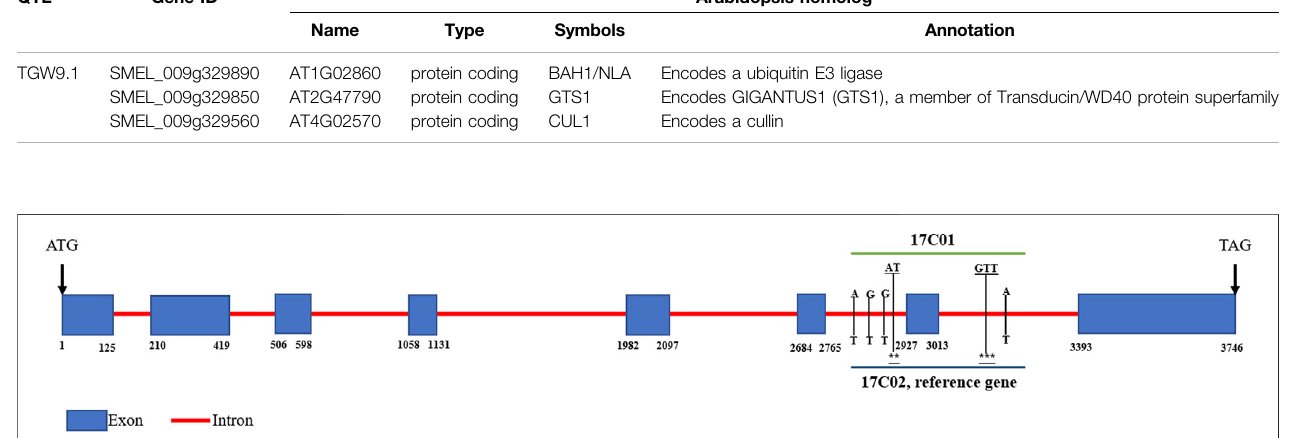
FIGURE3| Thegenomicsequence alignmentsofSMEL_009g329850 between17C01 and 17C02.The black rectangles and red lines were designatedas exons and introns, respectively. The vertical bar, 17C01 and 17C02 were placed on the up and down, respectively, represent nucleotide variation and the deletion, the * represented that there was no nucleotide in this site.